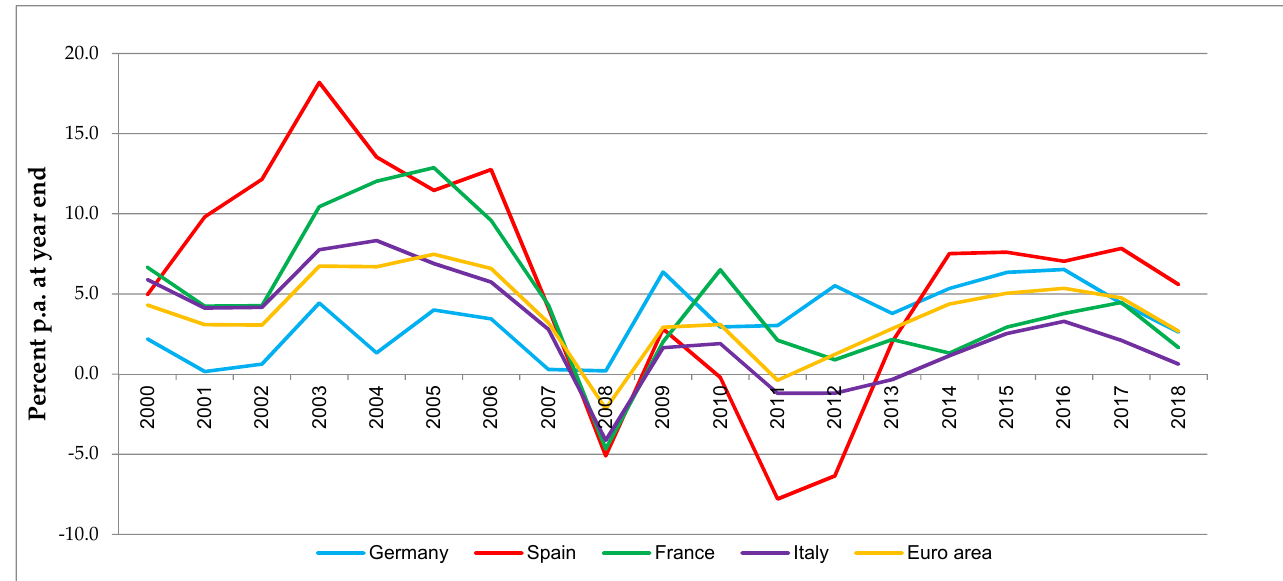
Figure 2. Real returns on euro area households’ total wealth. Source: authors’ calculations based on ECB, Eurostat, OECD, Thomson Reuters.